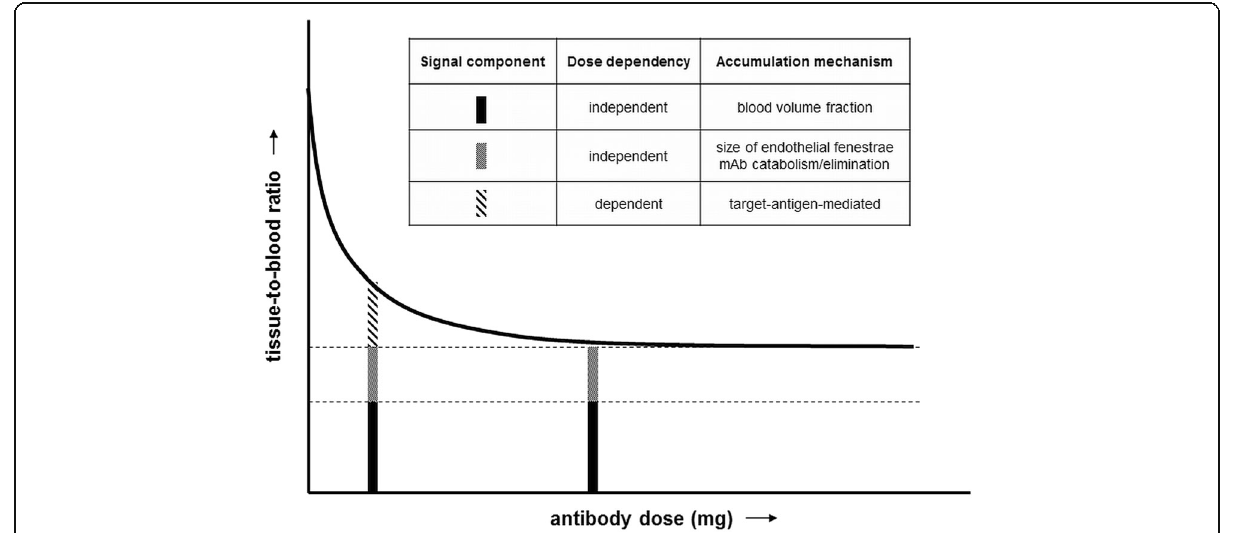
Fig. 1 Immuno-PET signal components in a phase I dose escalation study. The tissue-to-blood ratio is shown as a function of administered anti- body dose. For example, target antigen-mediated uptake is dose-dependent, while blood volume fraction, catabolism or elimination are dose-independent accumulation